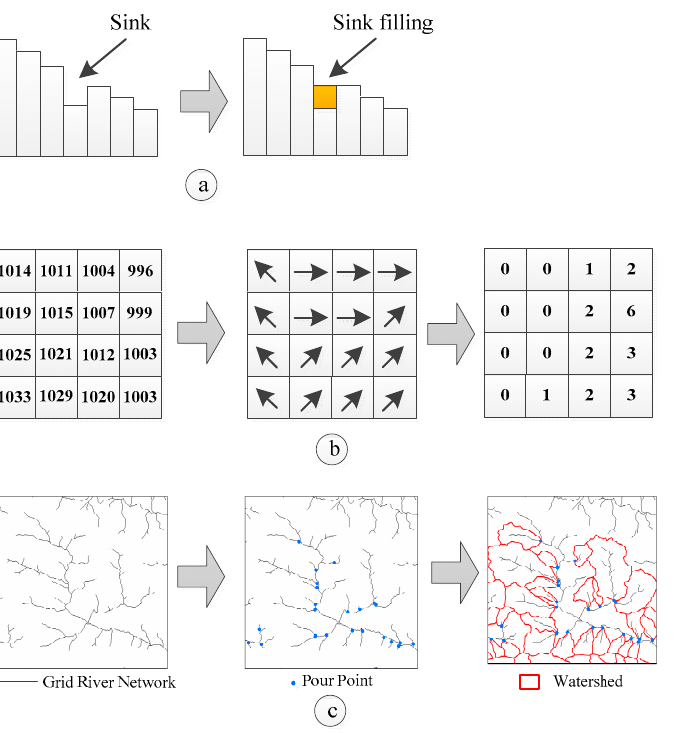
Figure 4. Watershed extraction. ( a ) Generation of the sink-filling raster image; ( b ) Calculation of the flow direction raster image and construction of the flow accumulation raster image; ( c ) Generation of the river network and the gully line raster image, and drawing of the pour points and extraction of the watersheds.